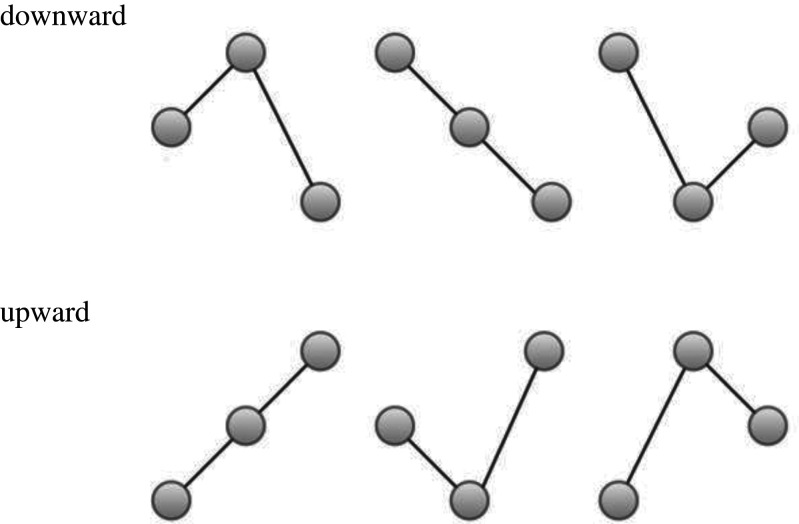
Elliot's upward and downward waves.